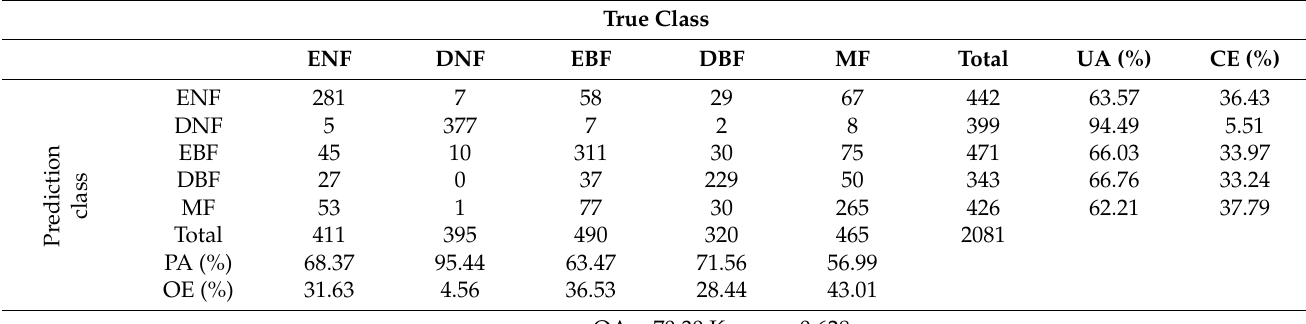
Table 11. Confusion matrix for the forest type classification map in